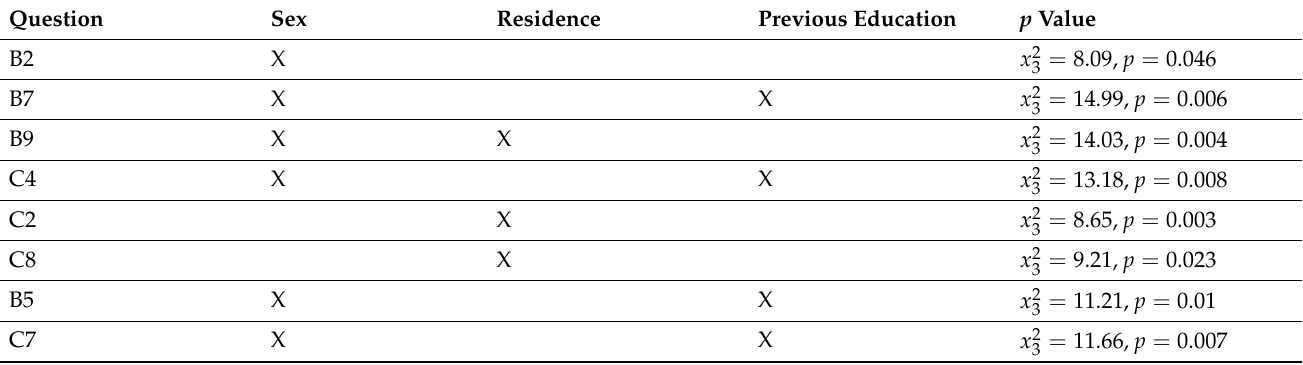
Table 4. Statistically Significant